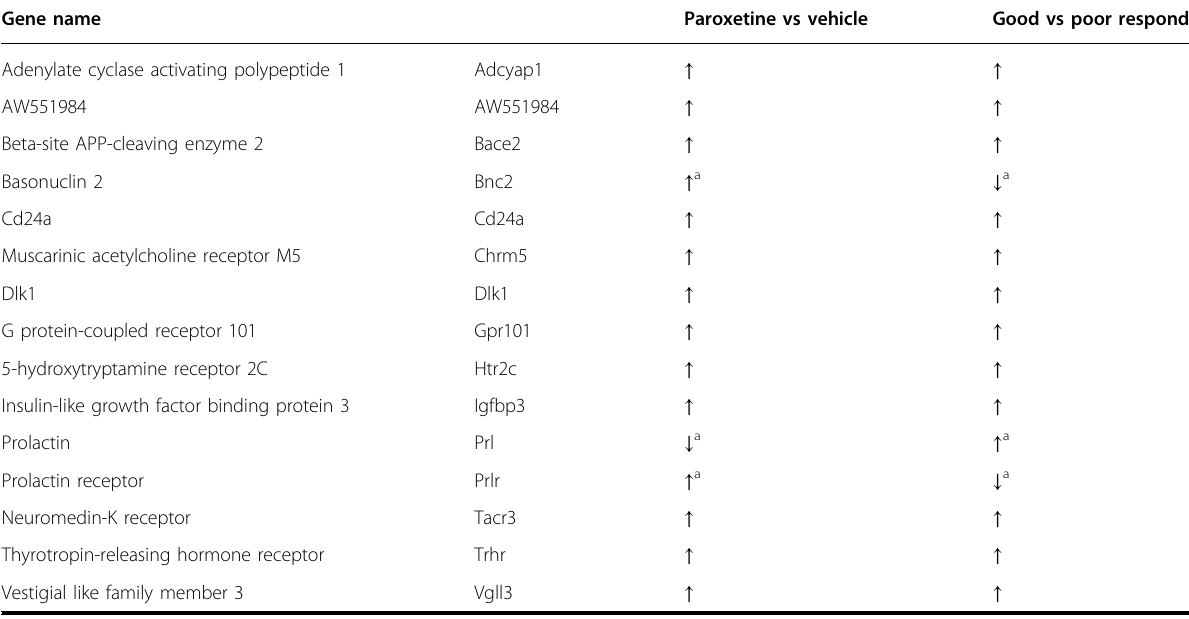
Table 1 Overlap between treatment- and response-associated differentially expressed genes.